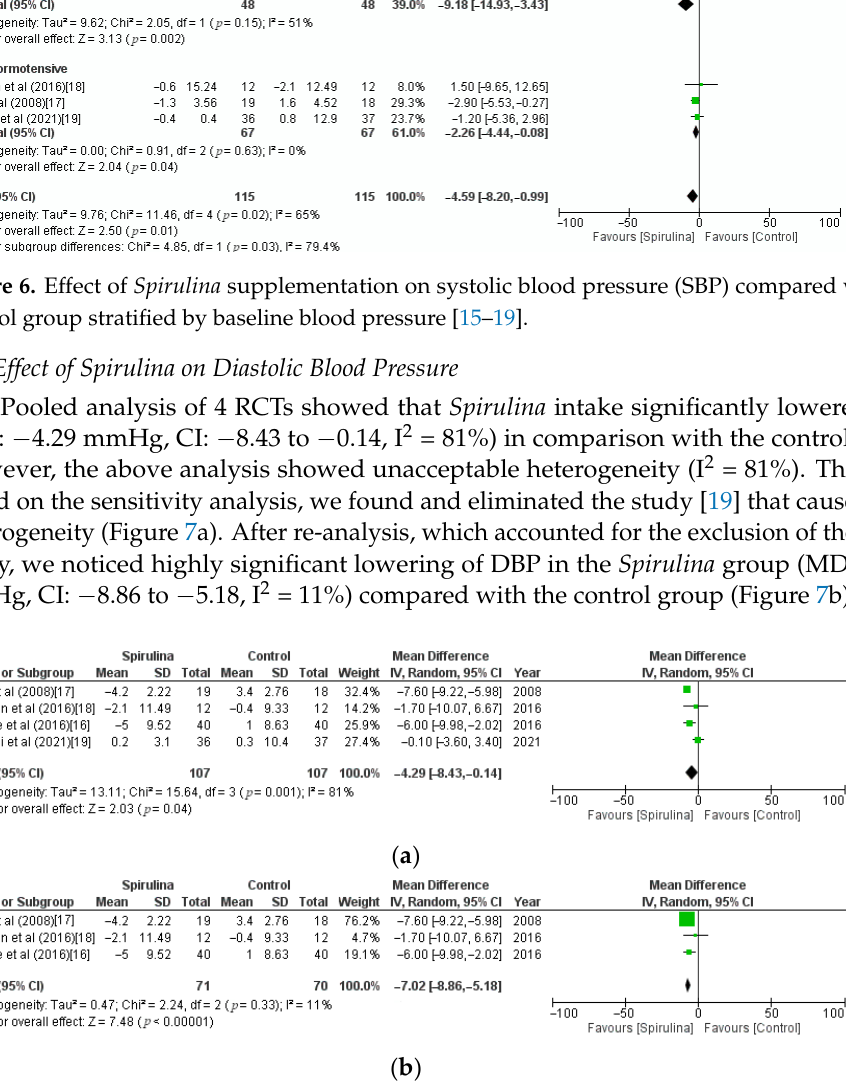
the control group stratified by baseline blood pressure [16–19]. ( b ). Effect of Spirulina supplementation on